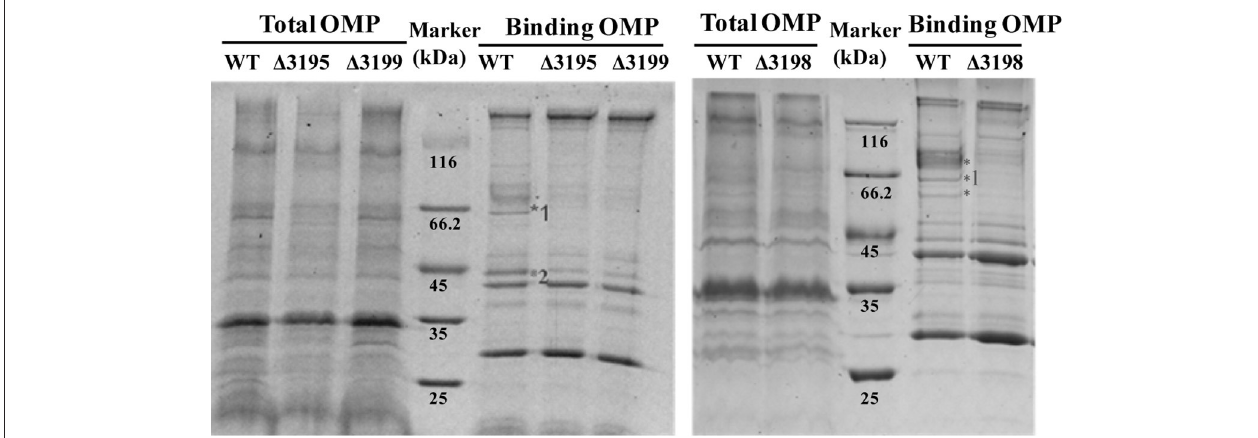
FIGURE 5 | SDS-PAGE analyses of the cellulose-bound outer membrane proteins (OMPs) isolated from WT and the t2s mutant strains cultured from PY10 medium supplemented with 0.4% glucose. Total OMPs amounts were calibrated for equal protein loading. Proteins were stained with Coomassie brilliant blue, and the figure color was adjusted as black and white for clear visualization. The bands missing or weakened in the profile from the mutant strains relative to that from WT were indicated by asterisk. The bands denoted with numbers were successfully identified to be CHU_1277 and CHU_1253, respectively by mass spectral analysis.